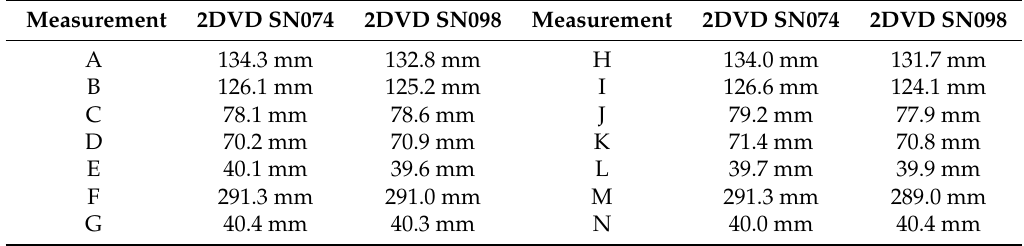
Table 1. The measurements used for determining the pixel sizes within the field of view; the letters in the “measurement” field correspond to the labels shown in Figure 2. All measurements are given to nominal 1 mm resolution. All distances were measured at least 3 times by at least 2 different people on different days and reported values within ∼ 0.5 mm of each other.